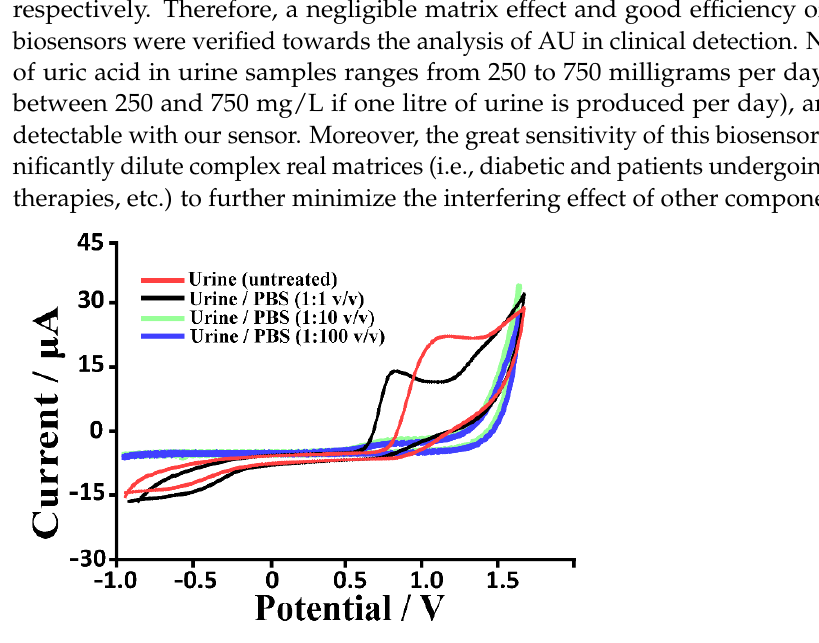
Figure 8. Cyclic voltammograms traces recorded using MWNT-CO 2 H-modified SPEs in diverse urine/PBS dilution ratio (untreated, 1:1, 1:10 and 1:100 v/v ). all traces are recorded at a scan rate of 30 mV s − 1 .